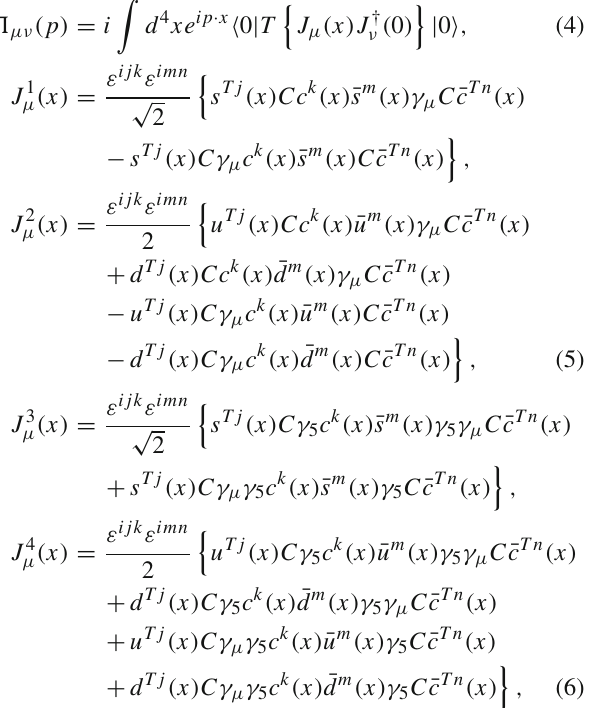
Table 1 The OPE denotes truncations of the operator product expansion up to the vacuum condensates of dimension n , the No denotes the vacuum condensates of dimension n (cid:5) are not included